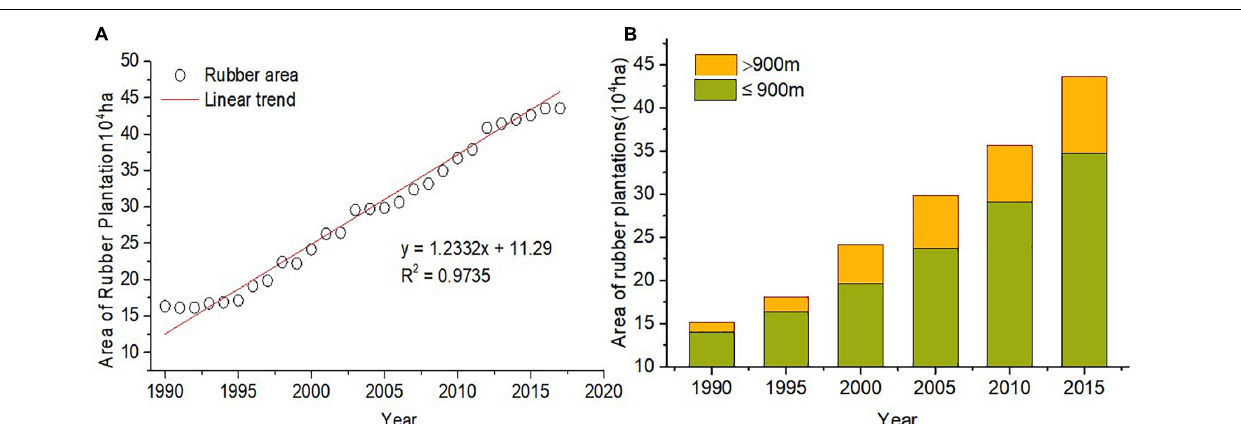
Table 3 . Precipitation in Xishuangbanna decreased at a rate